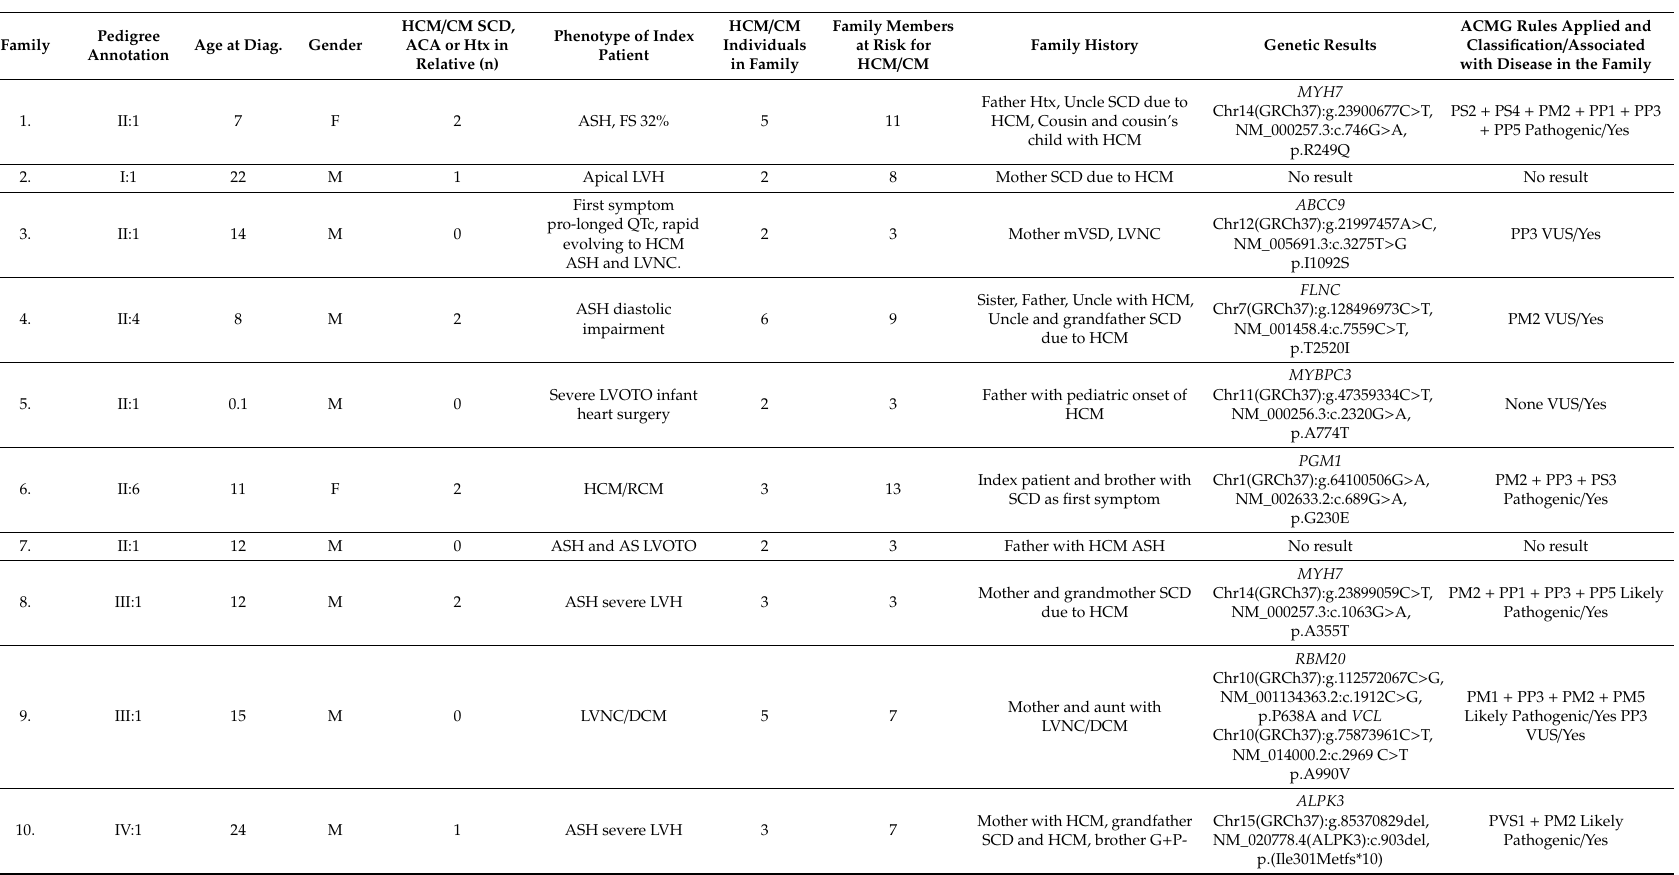
Table 2. Demographics of the index-patients, genetic variants found and their families. ASH = asymmetric septal hypertrophy, AS = aortic stenosis, DCM = dilated cardiomyopathy, FS = fractional shortening, G + P- = genotype positive and phenotype negative, Htx = Heart transplantation, LVH = left ventricular hypertrophy, LVNC = Left ventricular non-compaction, LVOTO = left ventricular outflow tract obstruction, CM-gene panel = Next generation sequencing of 60 genes associated with SCD and cardiomyopathy, mVSD = muscular ventricular septal defect, RCM = restrictive cardiomyopathy, SCD = sudden cardiac death, Trio-exome = clinical exome (6794 genes with known clinical significance) in index patients and parents, ”trios”), VUS = variant of uncertain significance. HCM / CM SCD, HCM / CM Family Members ACMG Rules Applied and Phenotype of Index Family Pedigree Annotation Age at Diag. Gender ACA or Htx in Individuals at Risk for Family History Genetic Results Classification / Associated Patient Relative (n) in Family HCM / CM with Disease in the